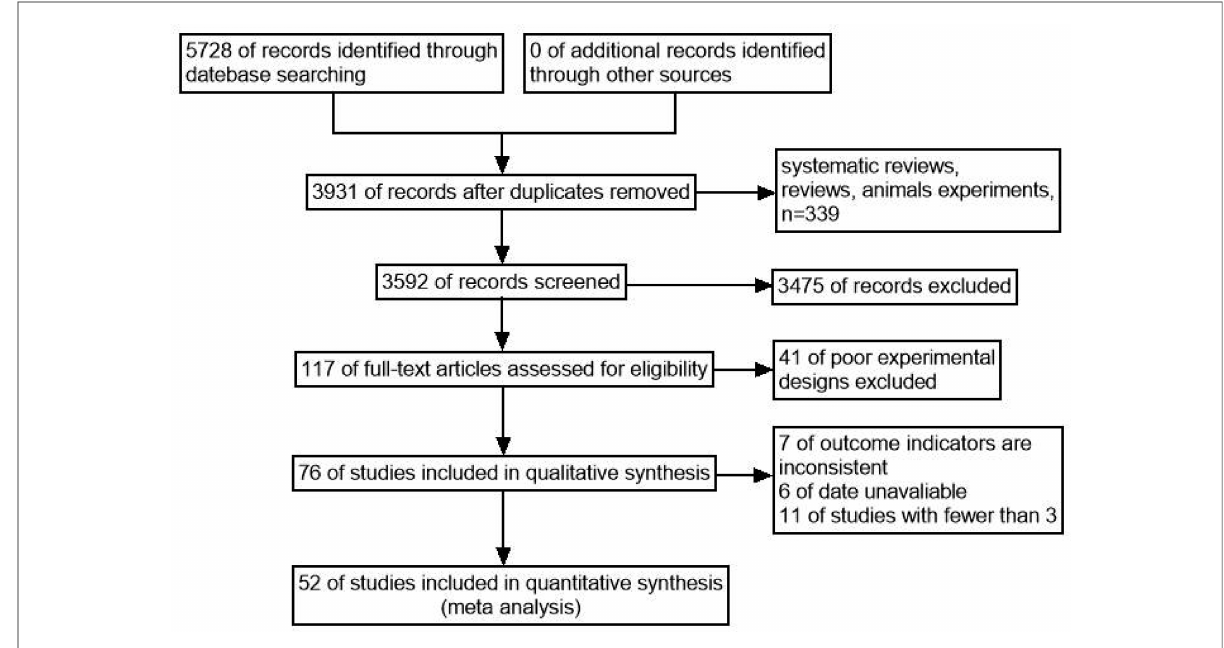
FIGURE 1 Flow chart of document